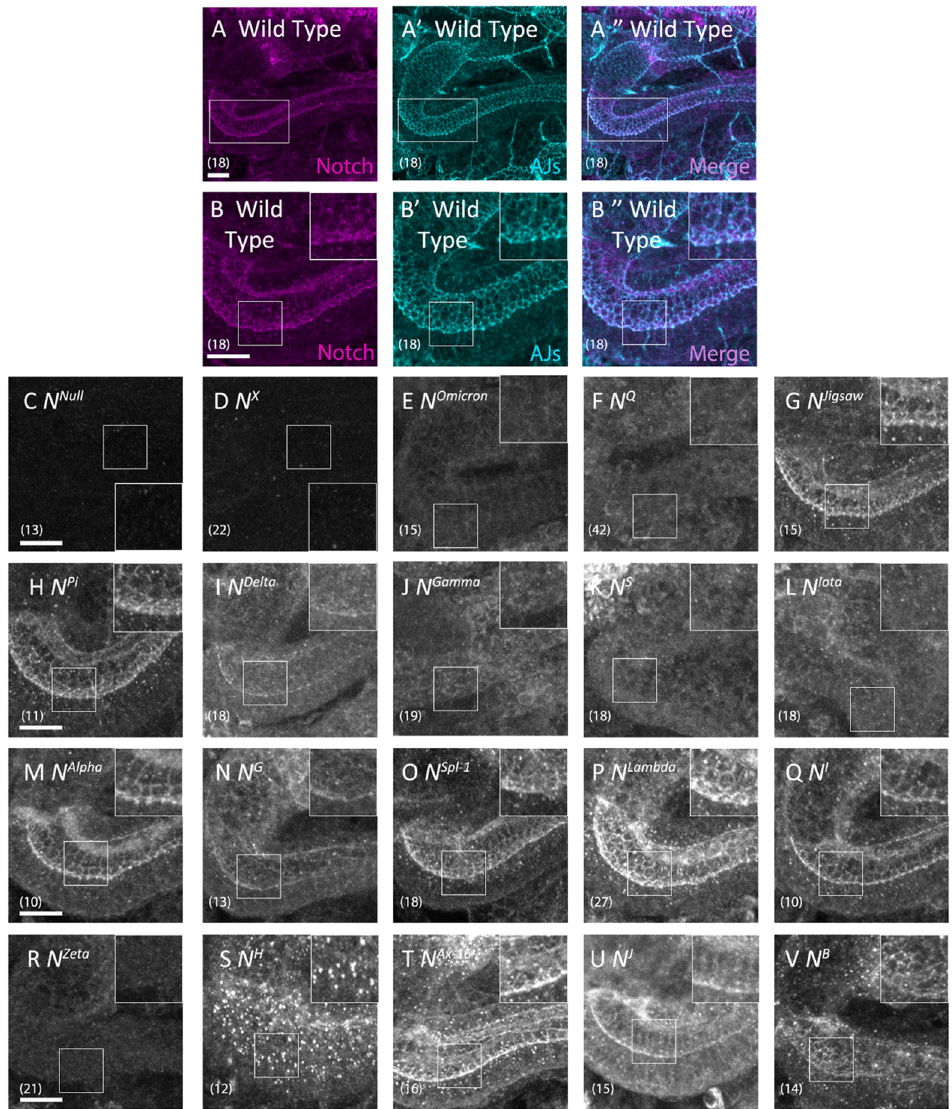
Figure 4. Notch alleles that disrupted intracellular Notch trafficking. ( A , A’’ and B , B’’ ) Notch and E- cadherin, a marker of adherens junctions (AJs), were detected in wild-type hindgut epithelium by anti-Notch (magenta in A , B ) and anti-E-cadherin (turquoise in A’ , B’ ) antibody staining. ( B , B’ , B’’ ) show high-magnification views of the regions outlined in ( A , A’ , A’’ ), respectively. Panels ( A’’ , B’’ ) are merged images of panels ( A , A’ , B , B’ ), respectively. ( C – V ) Notch was detected by anti-Notch antibody staining (white) in the hindgut epithelium of ( C ) N 55 e 11 , an amorphic allele of Notch ; ( D ) N X , ( E ) N Omicron , ( F ) N Q , ( G ) N Jigsaw , ( H ) N Pi , ( I ) N Delta , ( J ) N Gamma , ( K ) N S , ( L ) N Iota , ( M ) N Alpha , ( N ) N G , ( O ) N Spl − 1 , ( P ) N Lambda , ( Q ) N I , ( R ) N Zeta , ( S ) N H , ( T ) N Ax − 16 , ( U ) N J , and ( V ) N B hemizygotes. Insets are highly magnified images of regions outlined by white rectangles. The number of hindgut samples analyzed is shown in parentheses. Scale bars: 10 μ m.